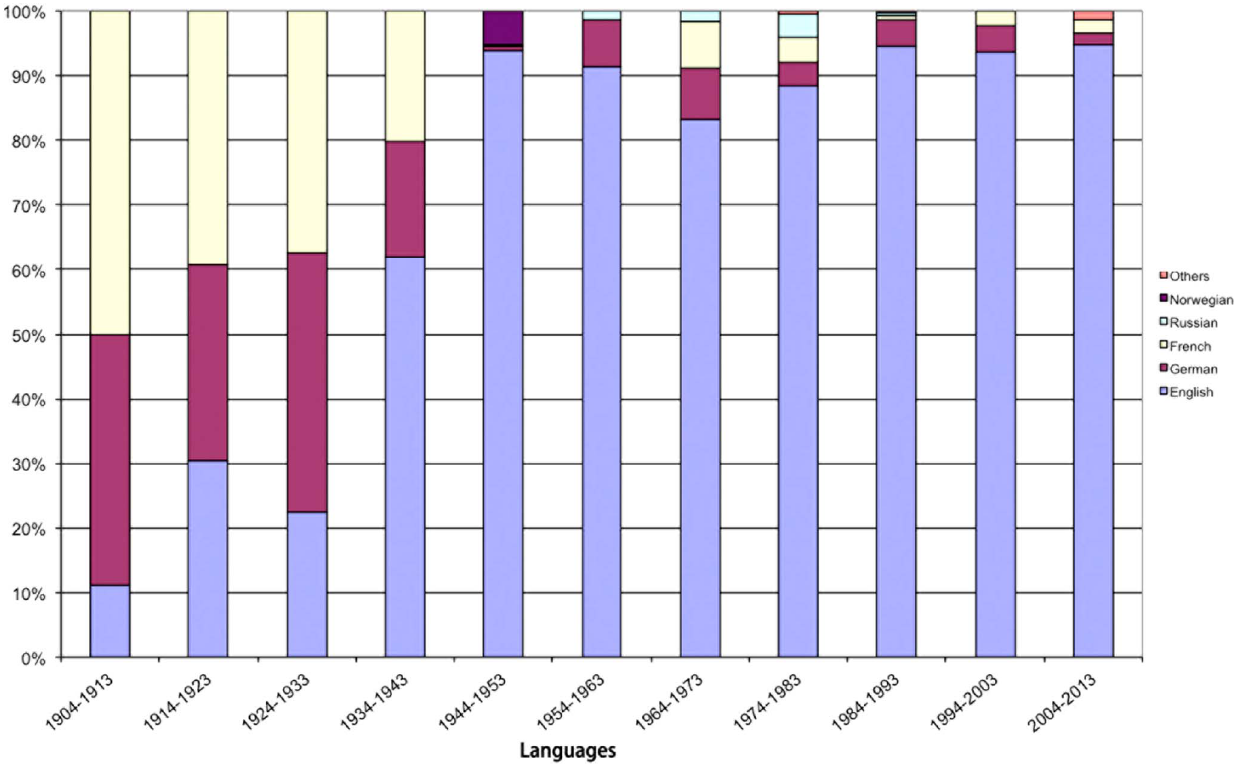
Figure 8. Shift of languages by decades.